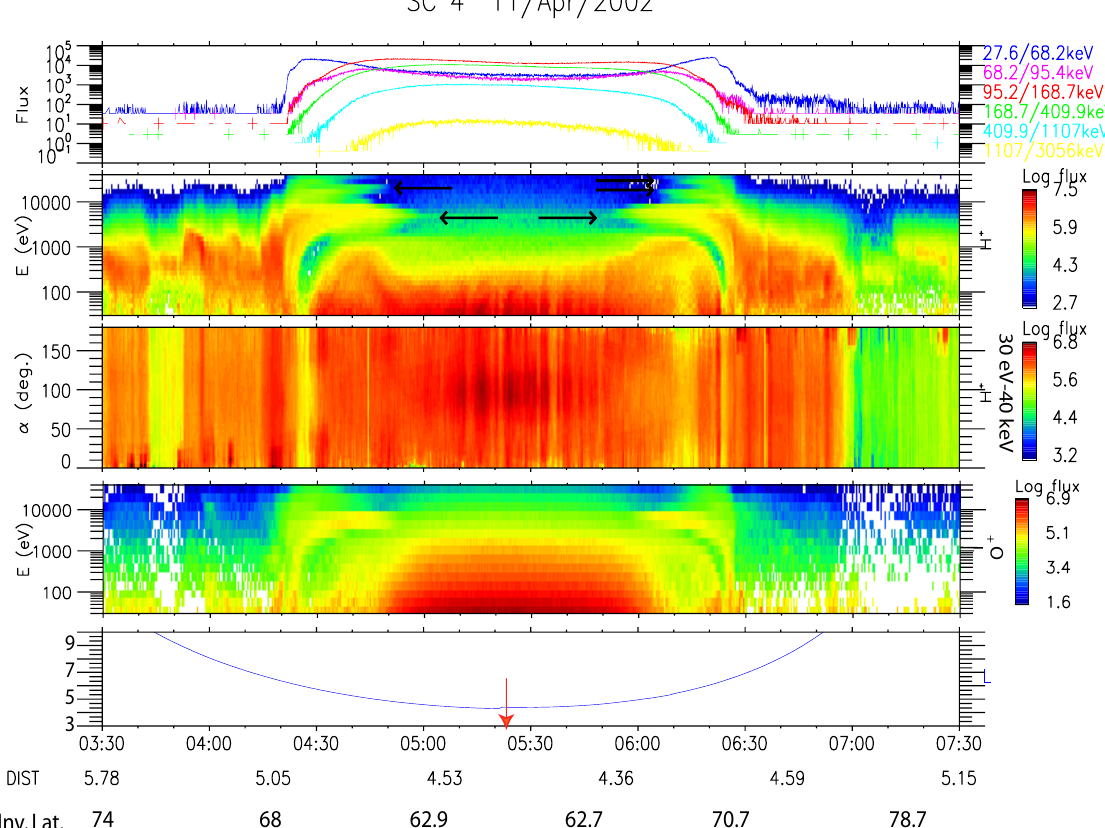
Fig. 3. SC4 particles data for the 11 April 2002 event. From top to bottom: RAPID proton flux in flux units, CIS/CODIF proton flux in flux units, the proton pitch angle distribution in flux units for the 30eV–40keV energy range, the O + flux in in flux units and the L-shell values crossed by the spacecraft. Radial distance in R E and invariant latitudes are indicated at the bottom of the plot. Red arrow indicated the equator